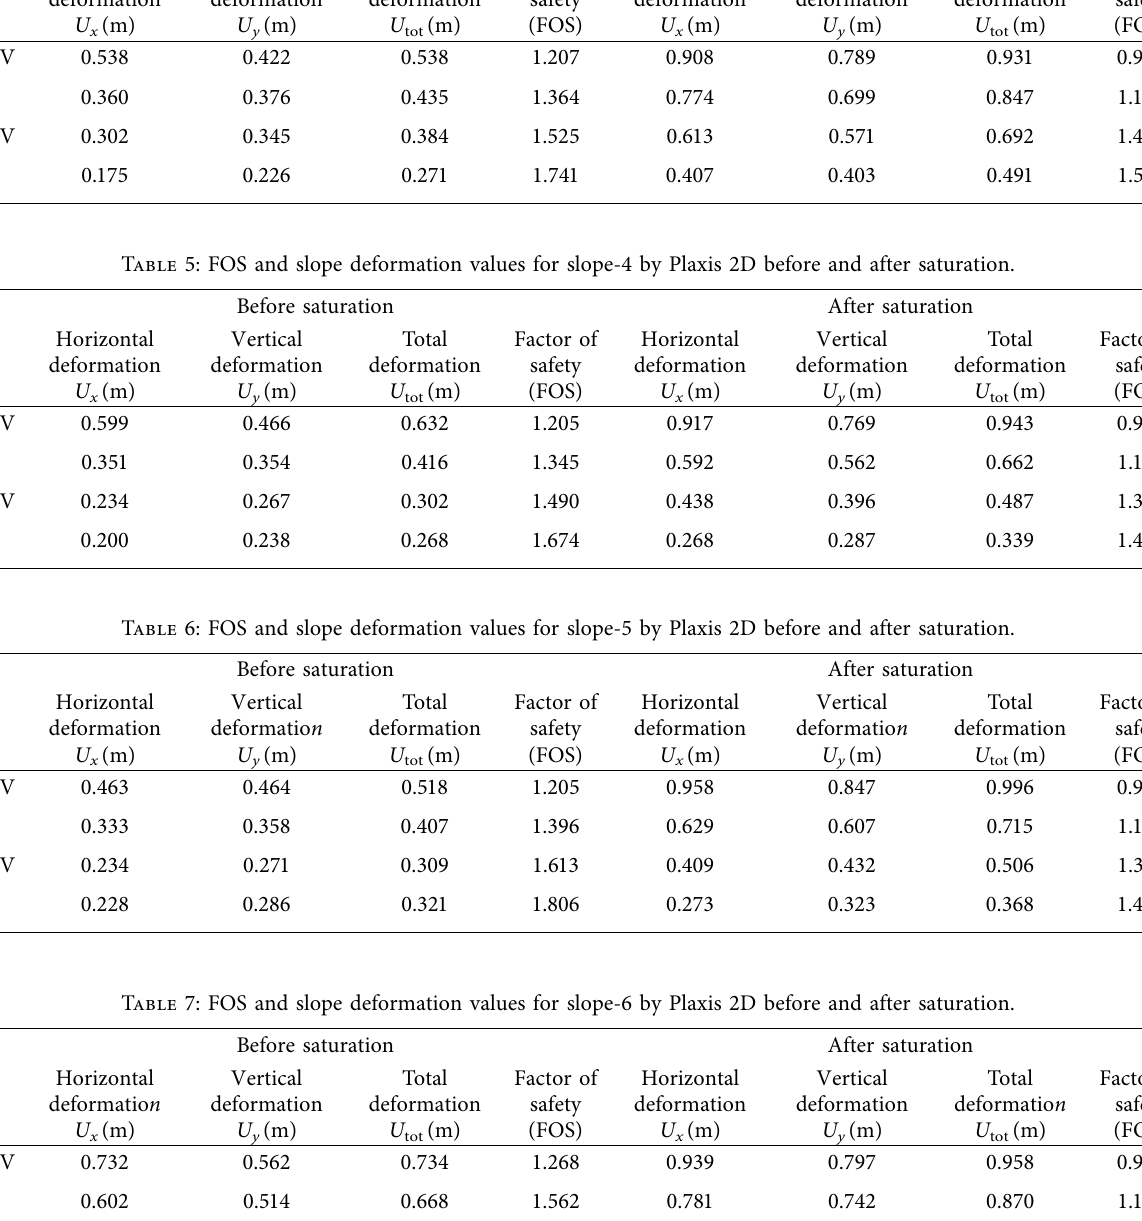
Table 4: FOS and slope deformation values for slope-3 by Plaxis 2D before and after saturation. Before saturation After saturation Slope Horizontal Vertical Total Factor of Horizontal angle deformation deformation deformation deformation U x (m)